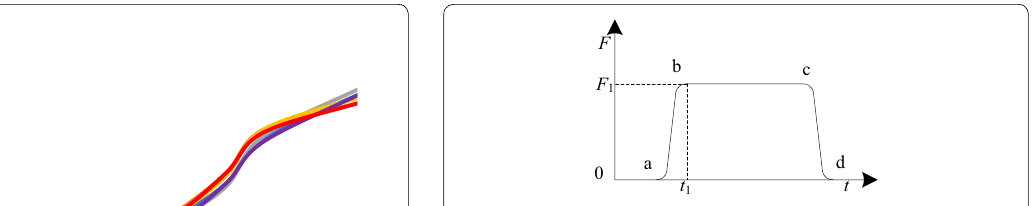
Figure 15 Force rising dynamic process